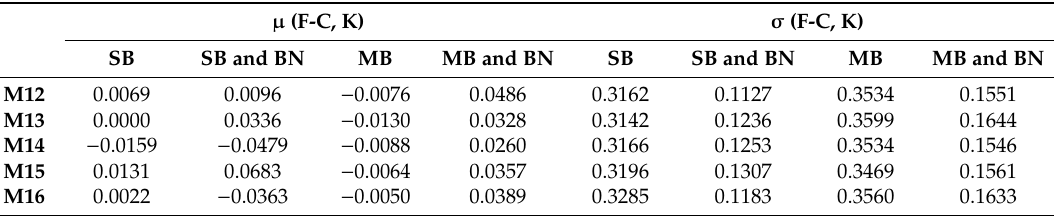
Table 2. Global F-C mean and STD for SNPP Visible Infrared Imaging Radiometer Suite (VIIRS) on